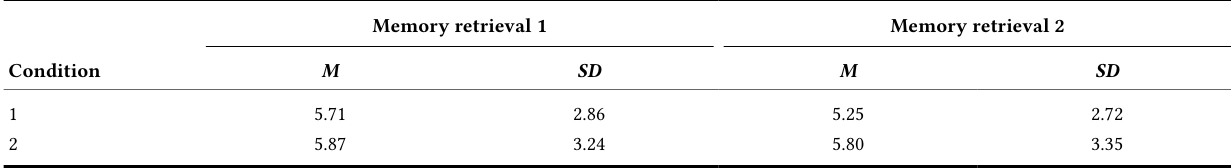
Experiment 3 memory performance (mean words recalled) across time for the two experimental conditions